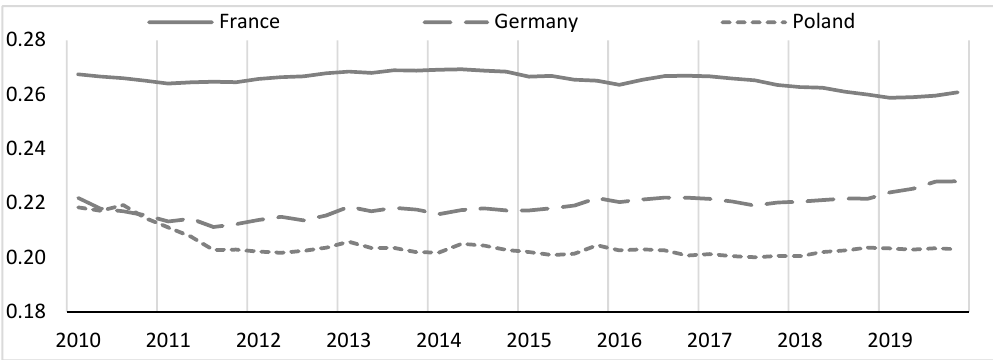
Figure 2. Government expenditure share in gross value added (factor g), own work, source: Eurostat.